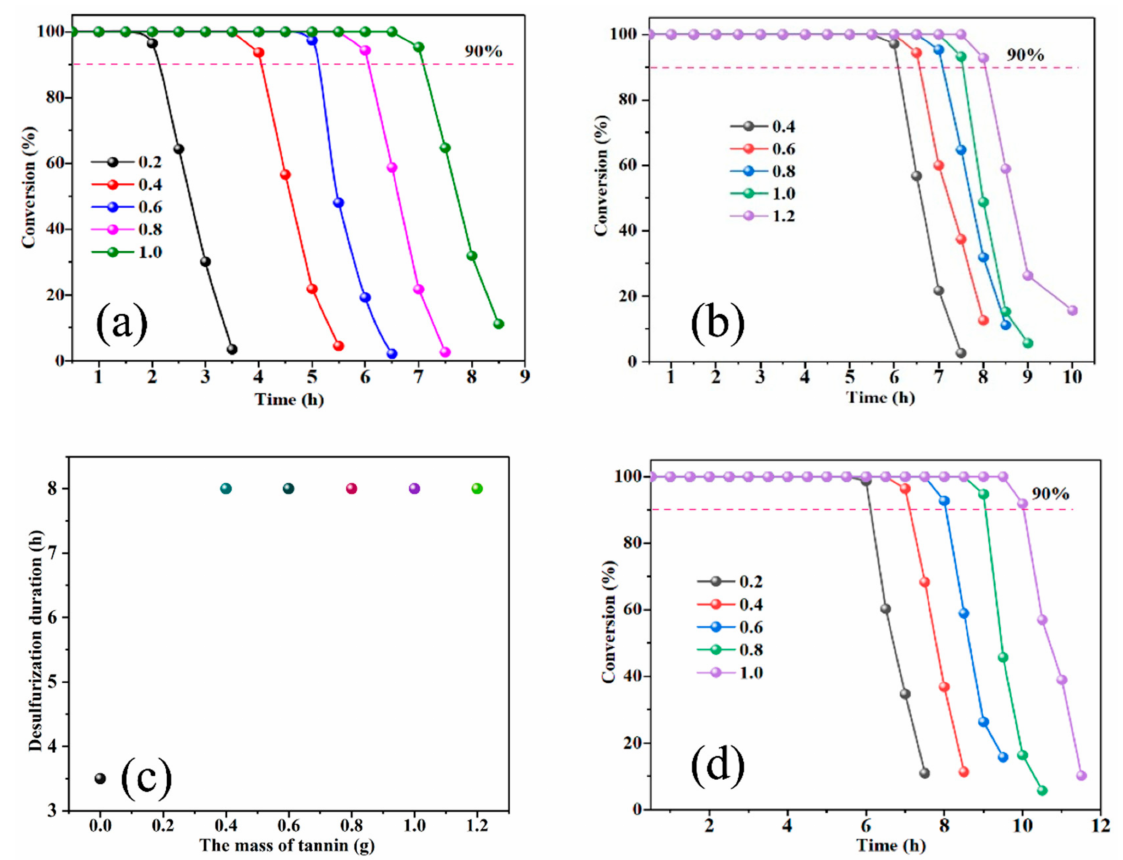
Figure 2. The conversion curve of H 2 S removal with various parameters: ( a ) the effect of total alkalinity from 0.2 to 1.0. ( b ) the effect of amount of Na 2 CO 3 : 0.4–1.2 g. ( c ) the effect of amount of TE: 0.4–1.2 g. ( d ) the effect of amount of NaVO 3 : 0.2–1.0